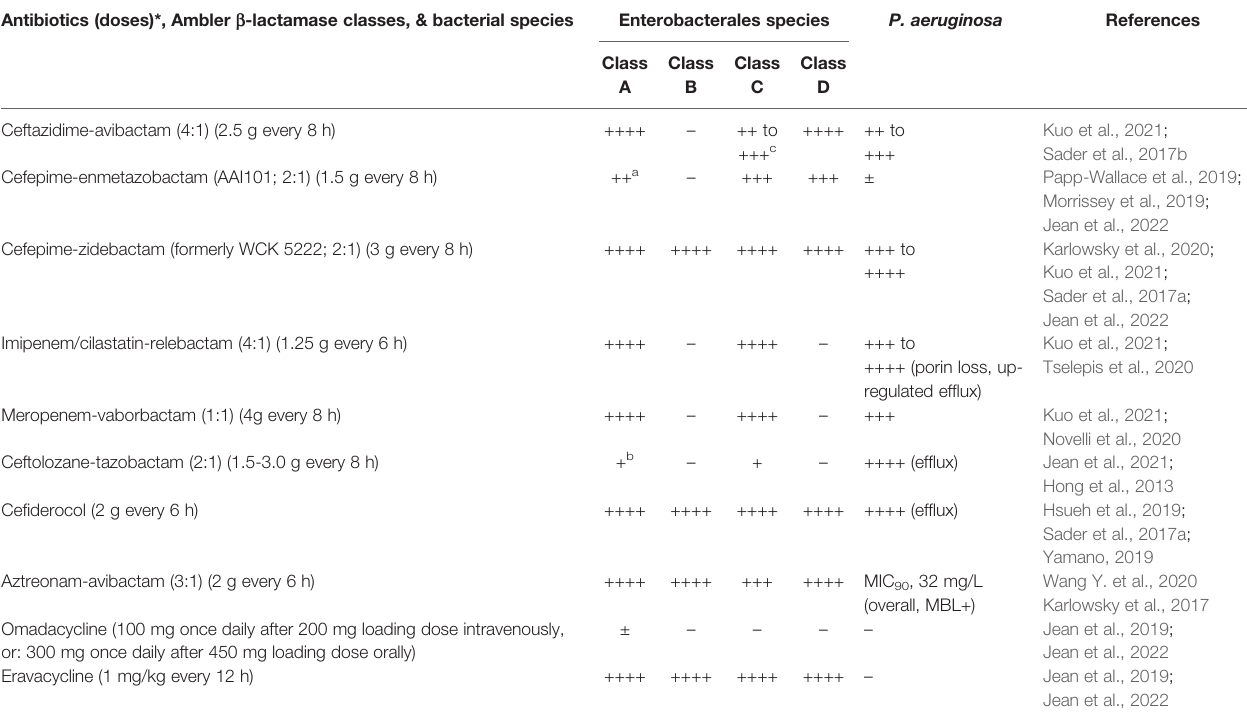
TABLE 4 | Comparison of spectra among novel antibiotics against carbapenem-resistant Gram-negative bacteria (Enterobacterales species, and Pseudomonas aeruginosa ). Antibiotics (doses)*, Ambler b -lactamase classes, & bacterial species